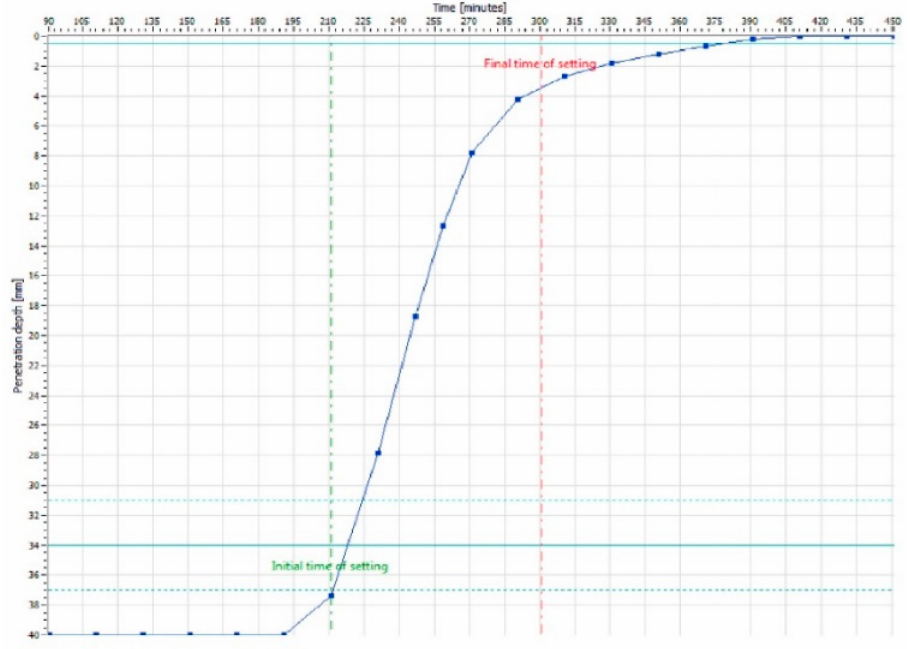
Figure 4. Graph of the dependence of the needle immersion depth in initial time of the setting as a function of time.